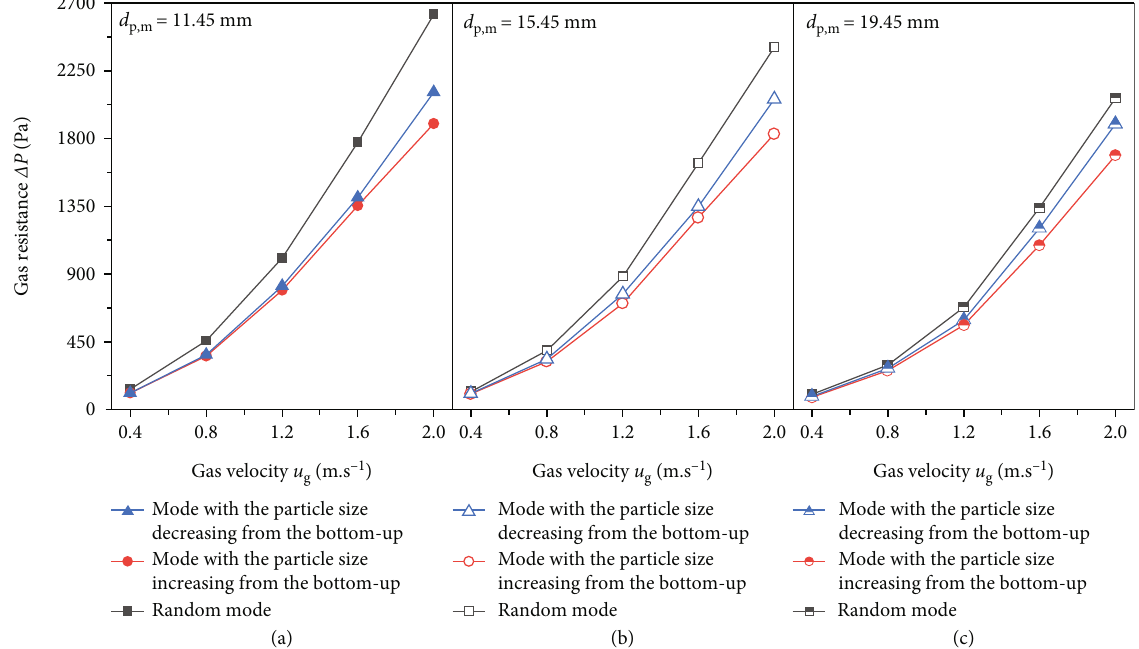
Figure 13: The comparison of the gas fl ow resistance ( Δ P ) between the random distribution mode and two kinds of fi ve-layer distribution modes under the three kinds of sinter mixtures: (a) d